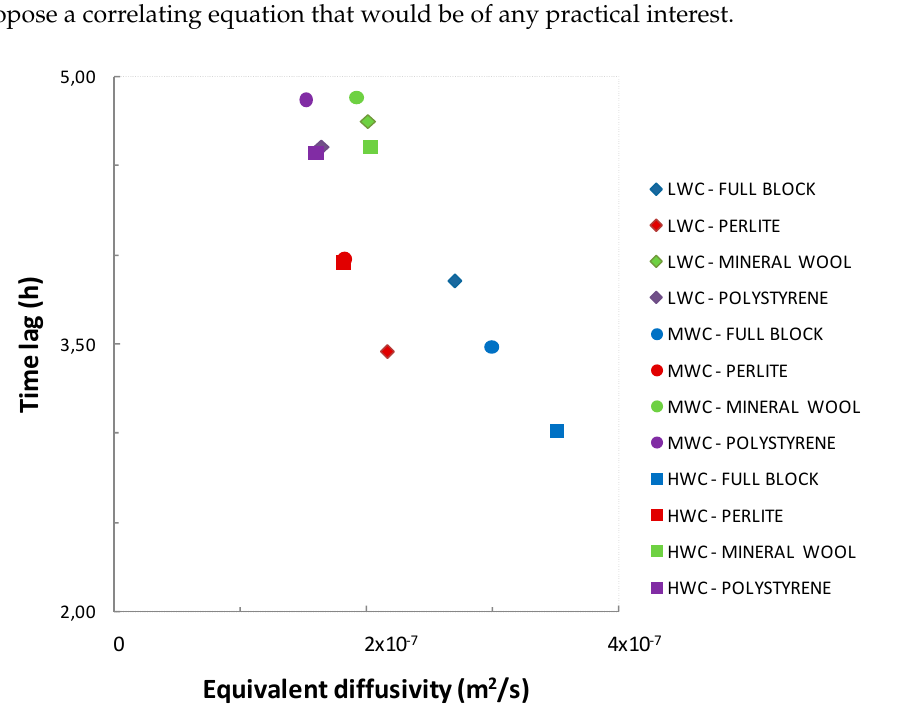
Figure 10. Time lag (in hours) vs. block equivalent diffusivity, all material combinations.